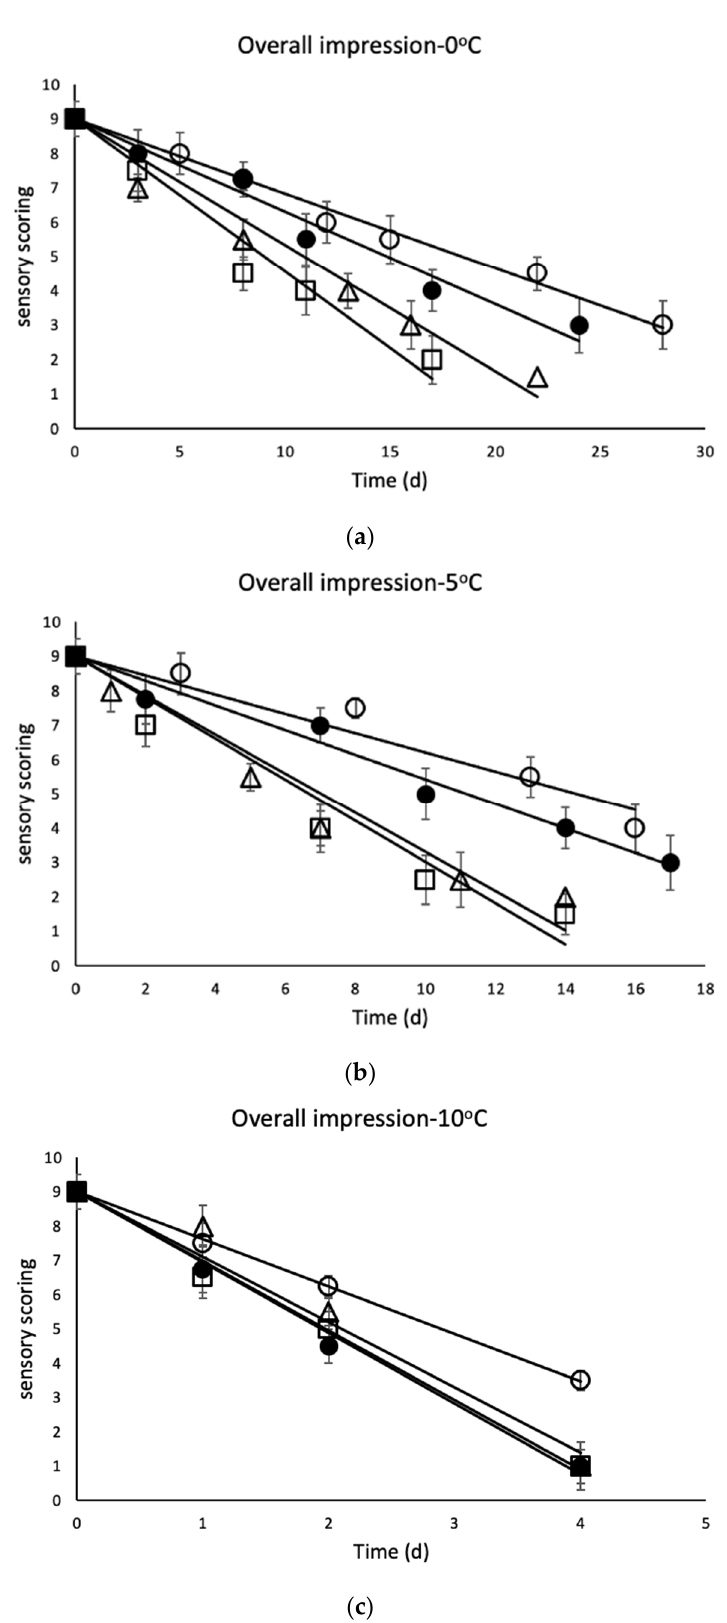
Figure 3. Sensory scoring (overall impression) of chicken stored at ( a ) 0 °C, ( b ) 5 °C, and ( c ) 10°C ( (cid:1) control, ● MAP, ○ EC-flav, △ EC-glu).